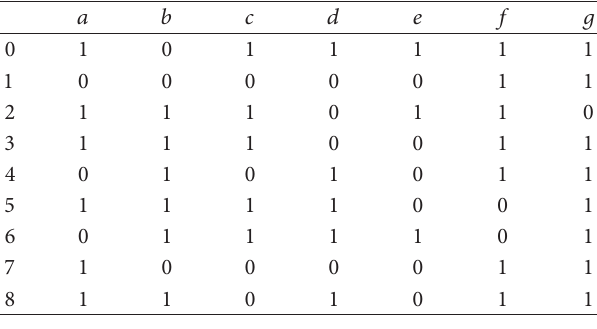
Table 1: A formal context that contains child-attributes.